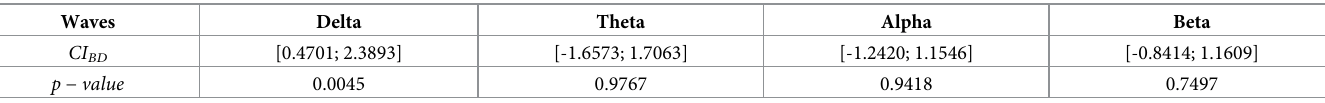
Table 3. Statistical comparison between the sample means of the network measure Δ for the groups B and D.